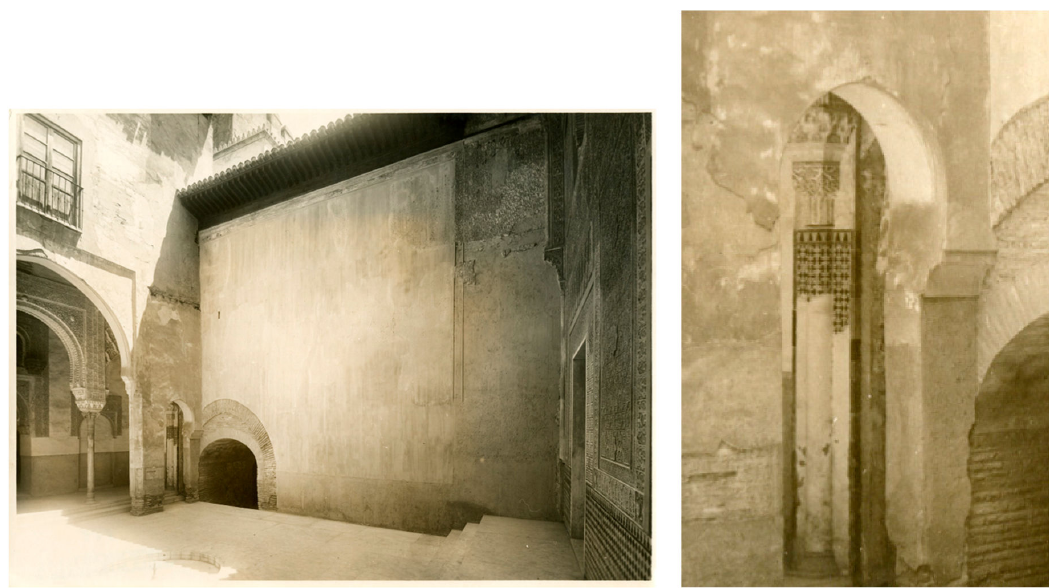
Figure 30. 16th century arch before dismantling and remains of the alicatado work which covered the top of the column shaft on the western edge of the Cuarto Dorado portico. See detail. Photograph by Manuel Torres Molina (undated). © Archivo del Patronato de la Alhambra y Generalife, Photograph Collection,